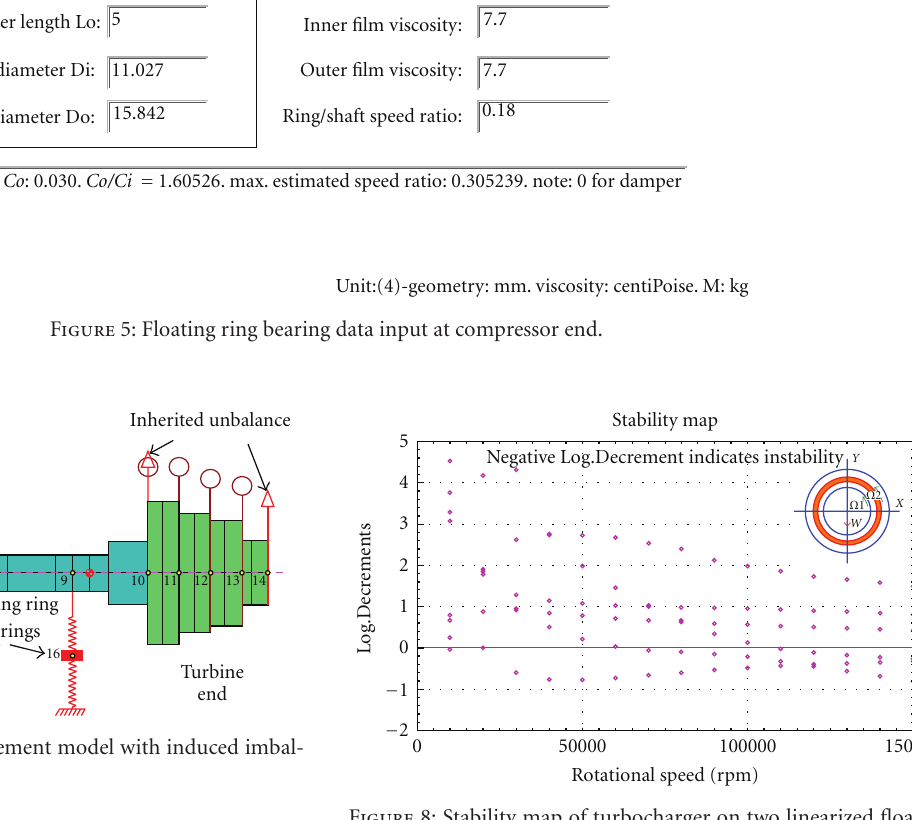
Figure 8: Stability map of turbocharger on two linearized floating ring bearings. (operating speeds, Ns = 10, 20, ... 150